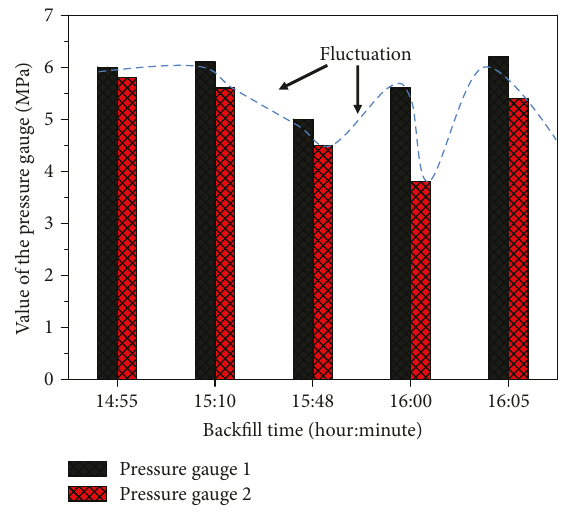
Figure 19: On-way resistance coe ffi cient and slump